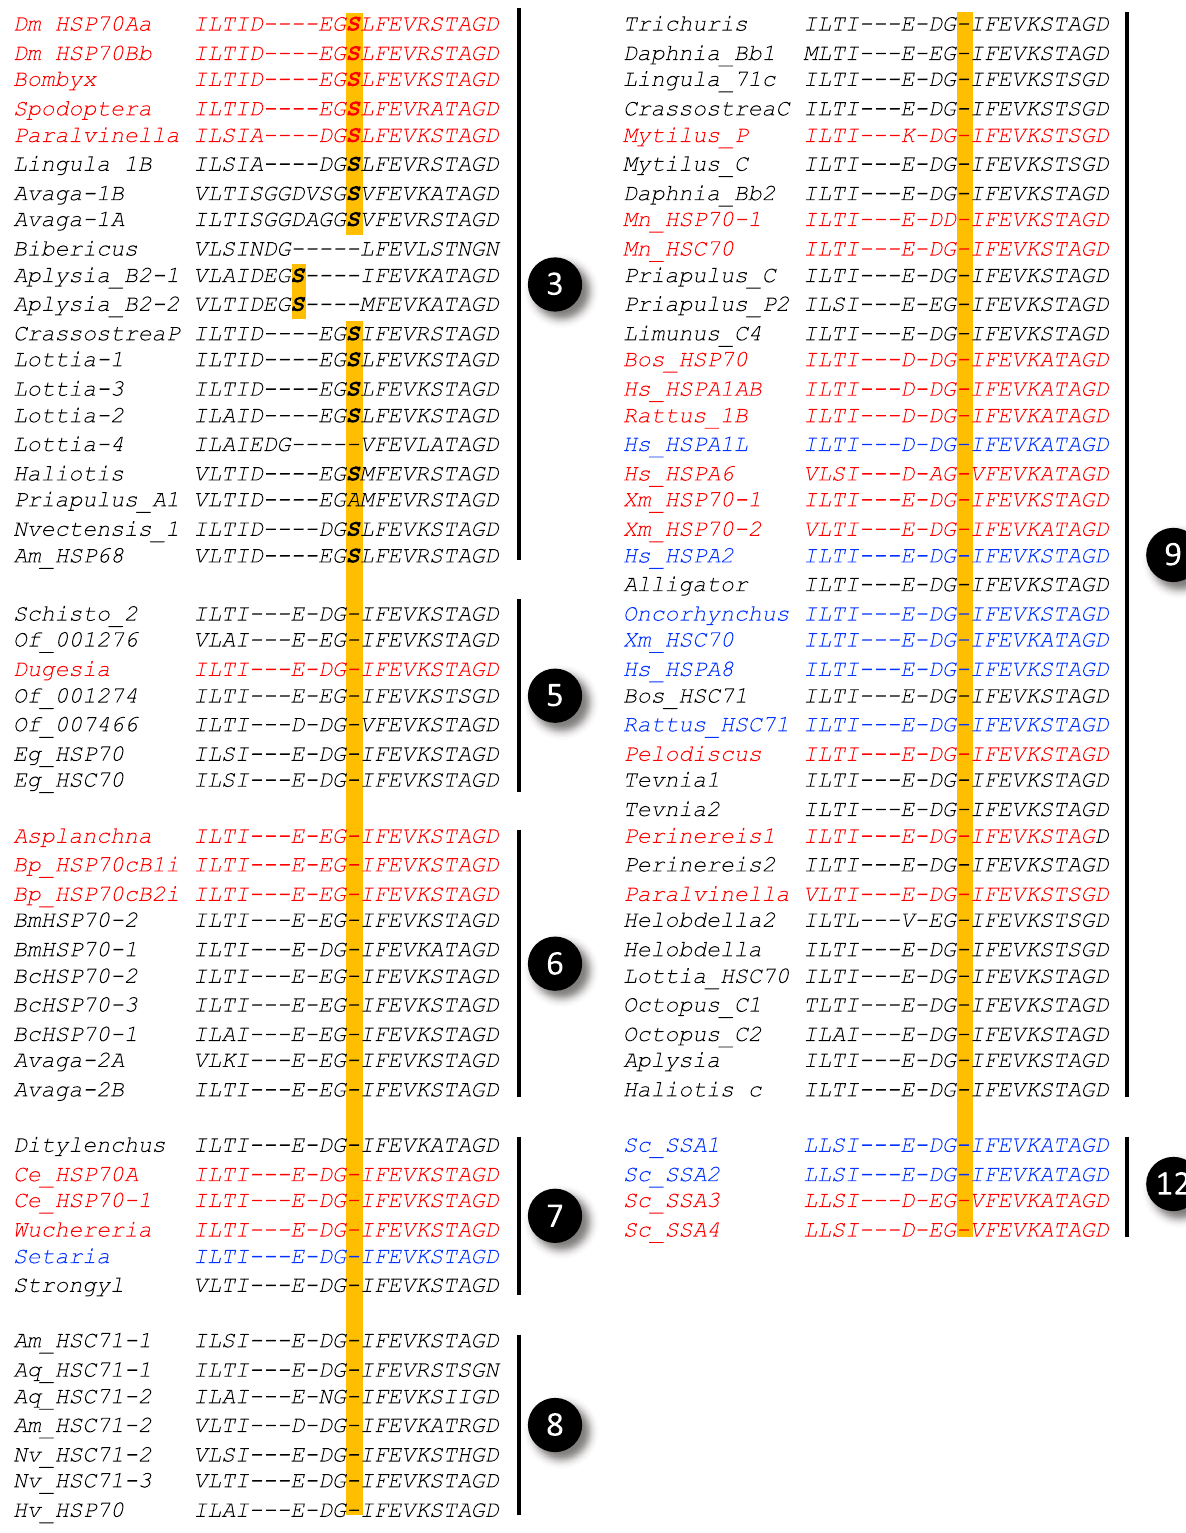
Figure 3. The serine residue specific to node 3. Cytosolic HSP70 family members in Fig. 1 were aligned by M-coffee, and sequences around the node 3-specific serine residue are shown in the same order as Fig. 1. Nodes in the phylogenetic tree (Fig. 1) are indicated on the right margin, and serine residues specific to node 3 are shown in bold with highlights. Stress-inducible and non-inducible genes are shown in red and blue, respectively. No data on the stress inducibility is available for genes shown in black. The accession numbers and other information are summarized in Supplementary Table